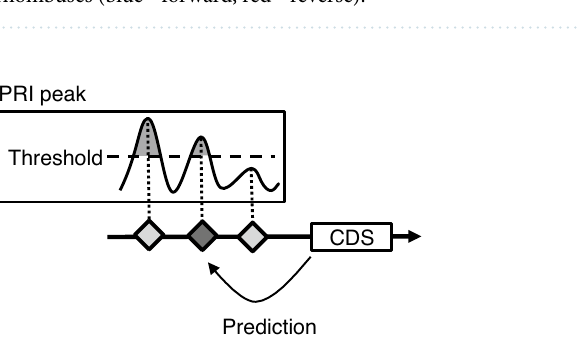
Figure 4. Gene model-associated TSS prediction for Genic Top promoters. One TSS is predicted for a gene. PRI peaks were searched for from the head of CDS in the upstream direction. The first peak over a threshold was selected as the predicted